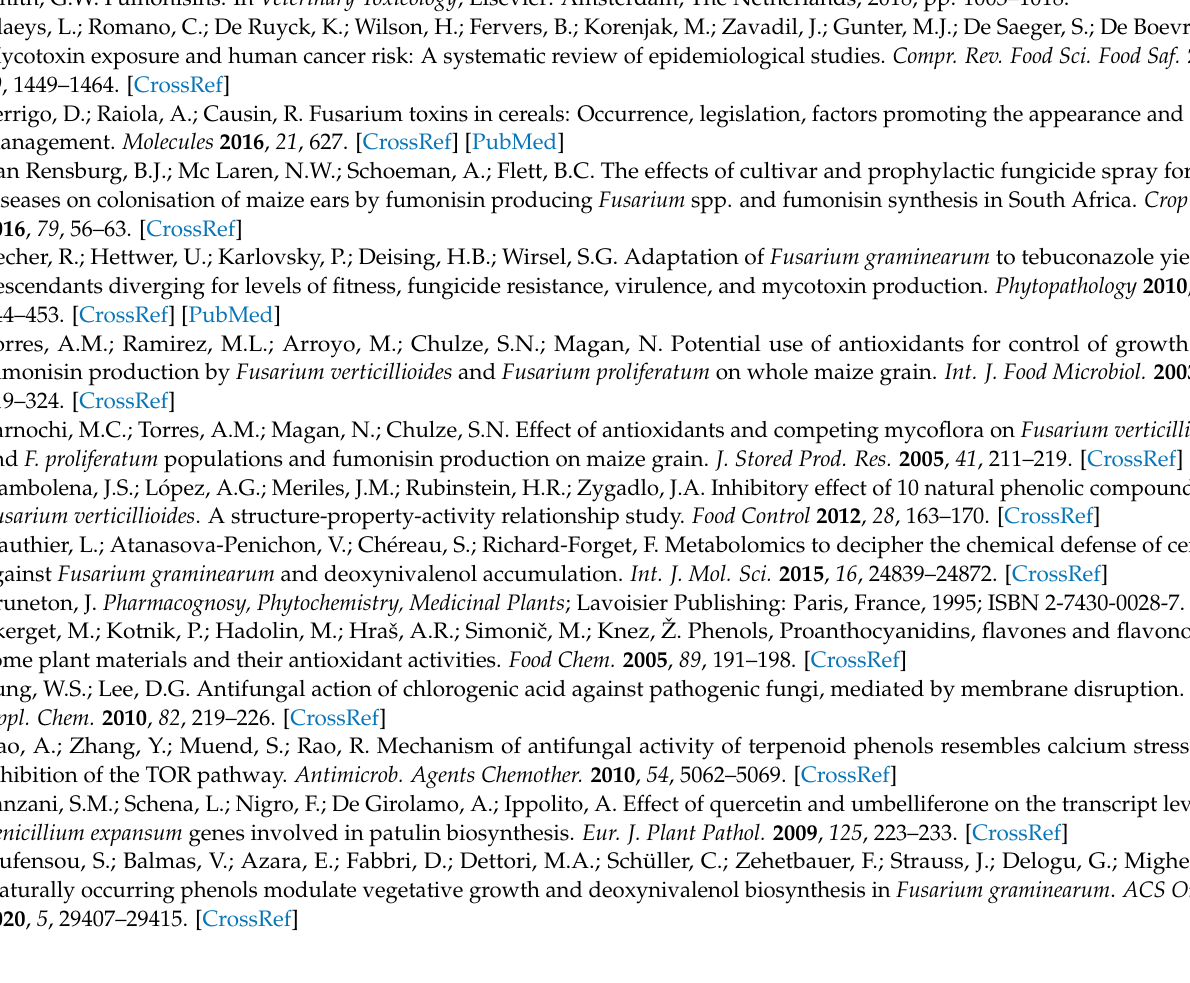
Table S2: pH values measured in the high-FB producer strain treated flasks; Table S3: pH values measured in the low-FB producer strain treated